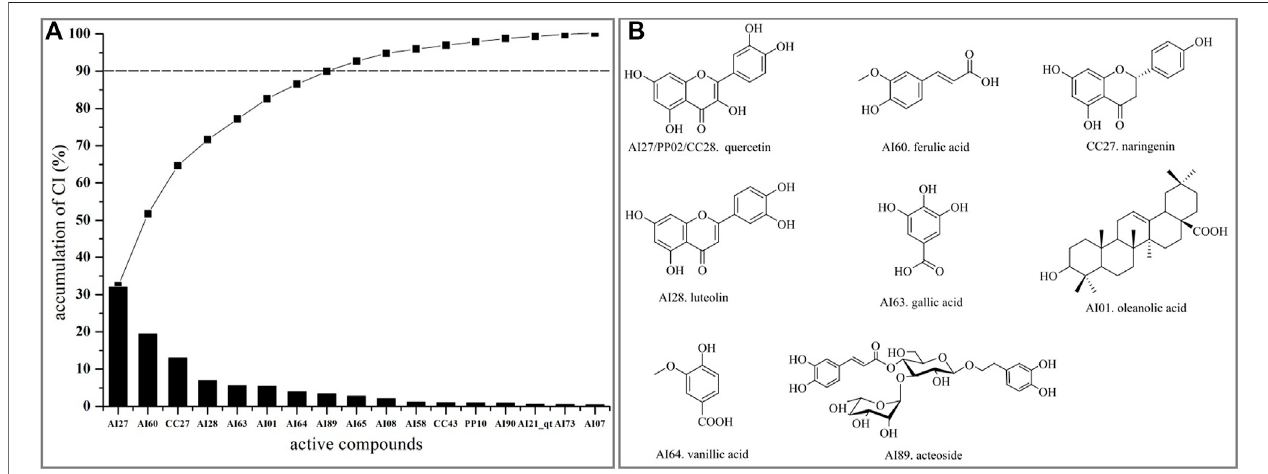
FIGURE5| CIvalueandactivecompoundsinLCS. (A) CIvalueandaccumulativeCIofactivecompoundsinLCS; (B) activecompoundsinLCSwithaccumulative CIs of more than